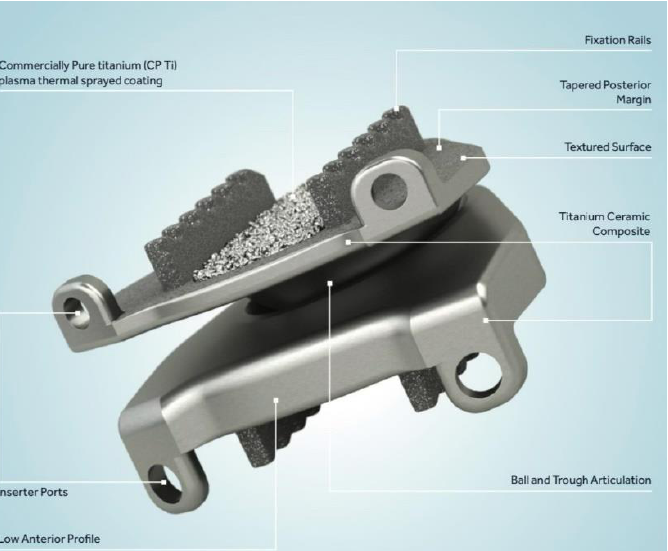
Figure 1. The Prestige cervical disc arthroplasty implant. It is composed of two metal endplate pieces with a ball and trough style articulation. Printed with permission from Medtronic PLC (Minneapolis, MN, USA).